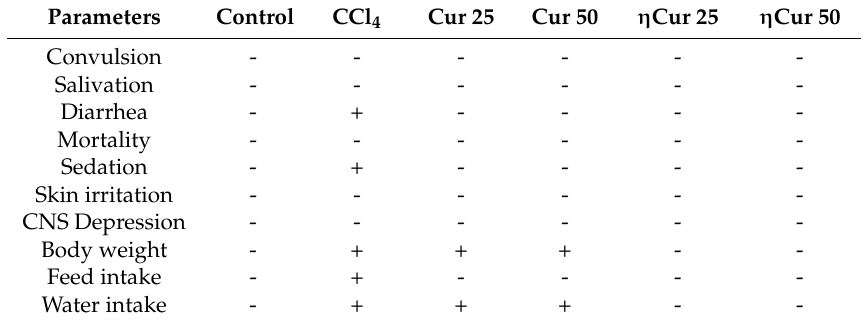
Table 1. Behavioral changes in experimental animals after treatment with η Cur and free curcumin.